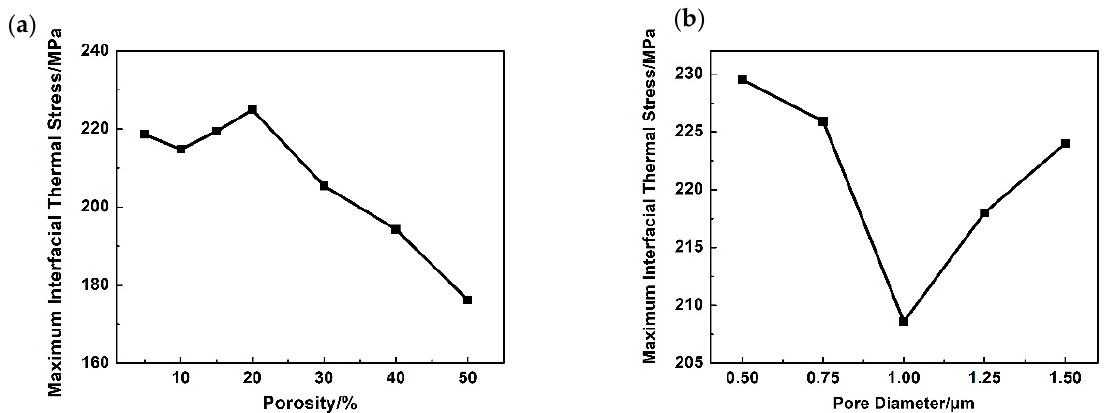
Figure 13. Plot of maximum interface stress versus porosity and pore diameter: ( a ) 1.5 μ m pore diameter, ( b ) 20% porosity.